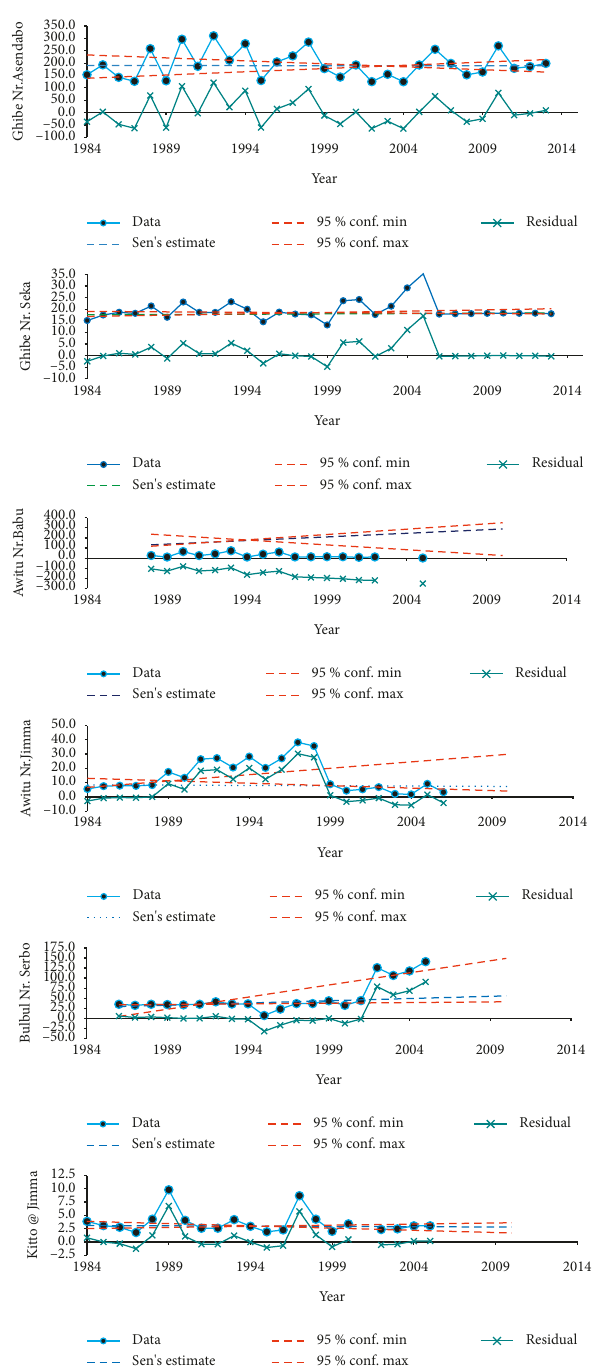
Figure 7: Trend for stream flows at six stations in Gigel Gibe in the